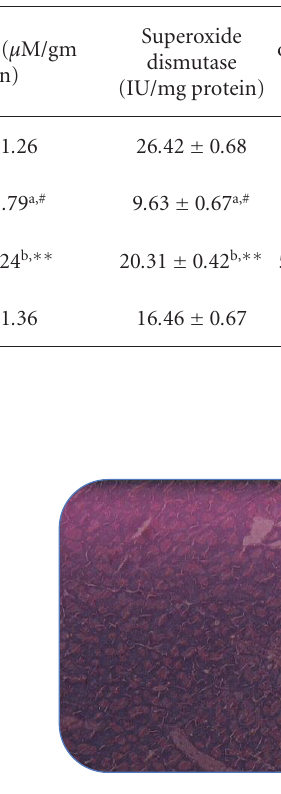
Figure 3: Pancreatic section of ethyl acetate fraction + STZ-treated rat stained with haemotoxylin and eosin.